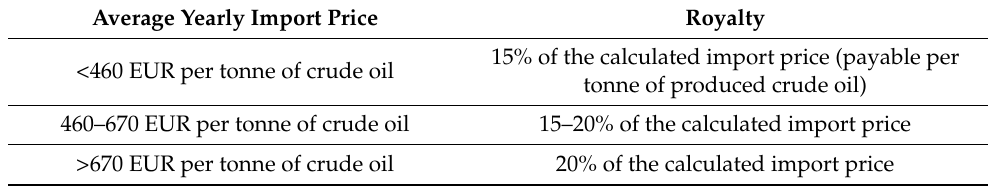
Table 4. Royalty for crude oil production in the Republic of Austria (sliding scale).